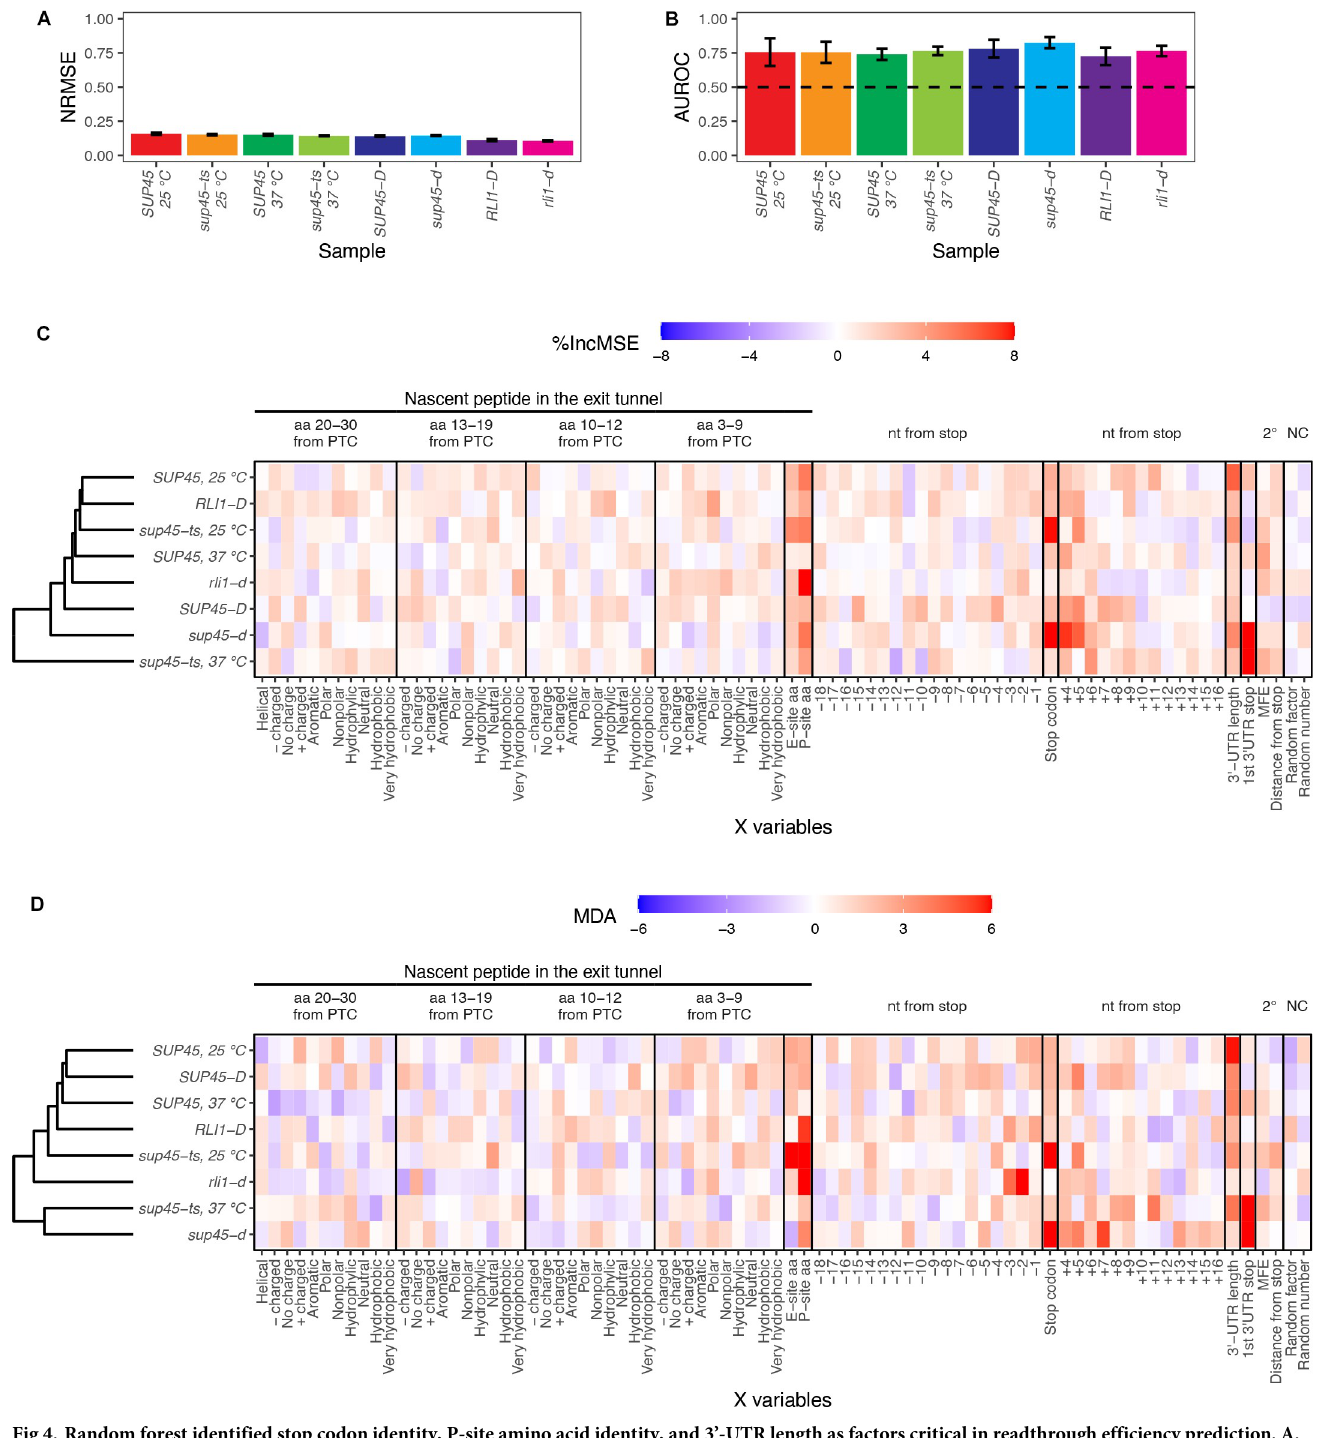
Fig 4. Random forest identified stop codon identity, P-site amino acid identity, and 3’-UTR length as factors critical in readthrough efficiency prediction. A. Performance metric for random forest regression displaying average Normalized Root Mean Squared Error (NRMSE) ± standard deviation across 5-fold cross- validation. B. Performance metric for random forest classification displaying average Area Under the Receiving Operator Curve (AUROC) ± standard deviation across 5-fold cross-validation. The value of 0.5 (dashed line) means the classification by the input X variables is no better than random chance. C. and D. Feature importance extracted from the random forest models. The relative importance of a feature is represented by percent increase in mean squared error (%IncMSE) for regression (C) and Mean Decrease Accuracy (MDA) for classification (D), which is percent increase in error that results from permuting the feature. The higher the %IncMSE or MDA is, the more crucial the feature is in predicting readthrough efficiency or correctly classifying genes into groups. Arbitrary continuous and discrete values randomly assigned to the genes (random number and random factor) are used as negative controls.